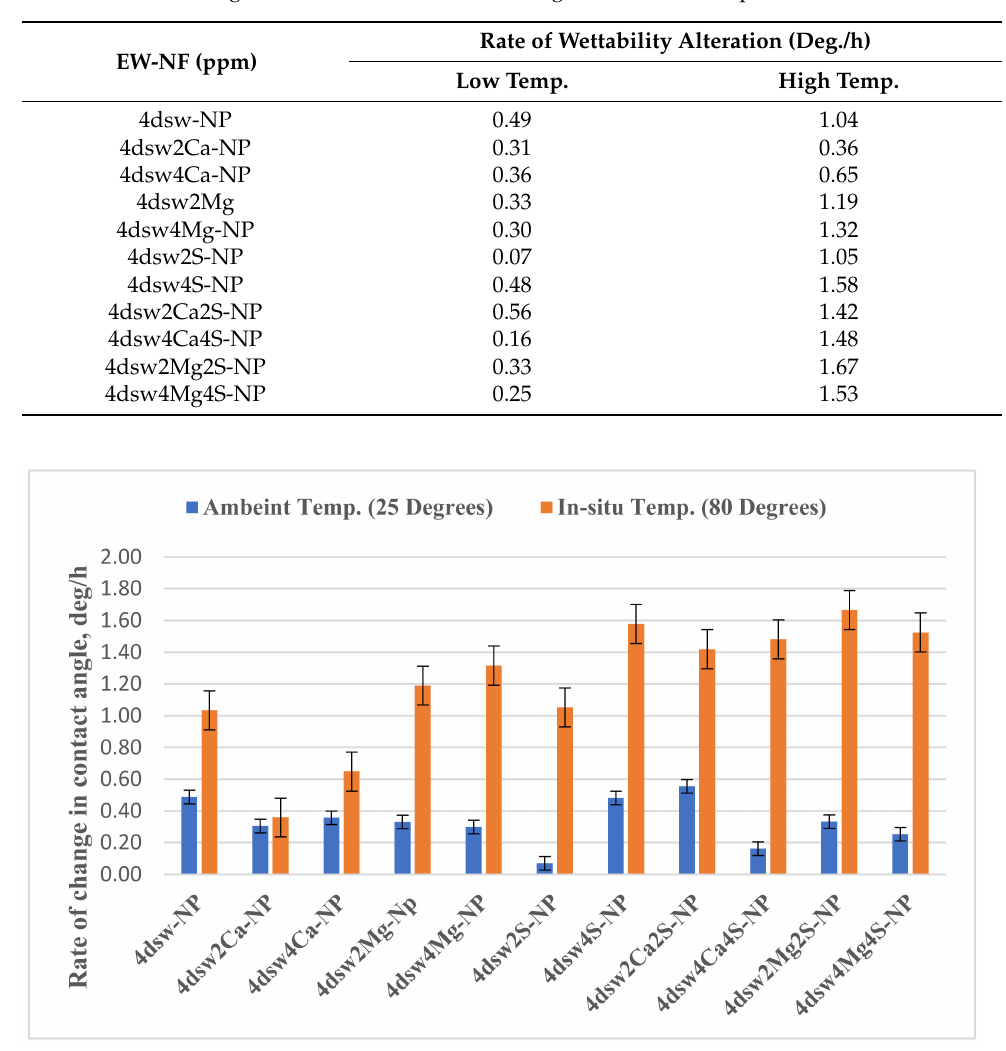
Figure 16. Effect of temperature on rate of change of wettability by